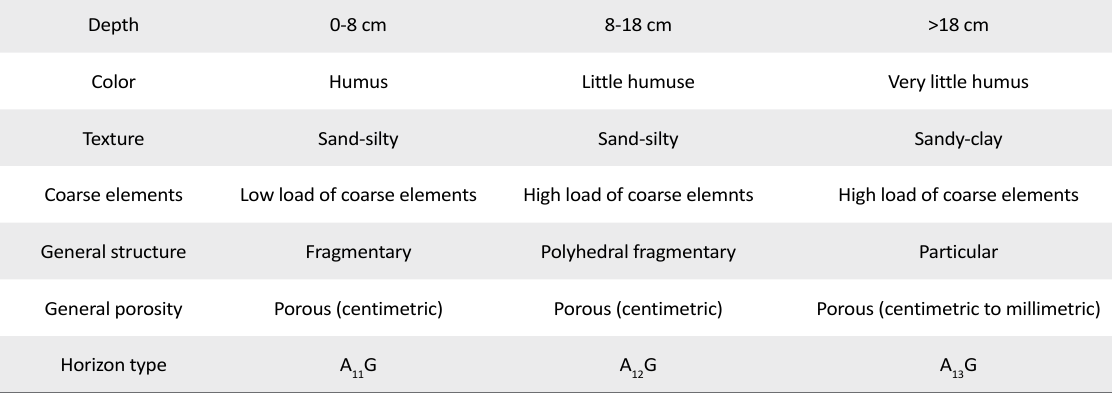
Table 2. Description of the soil profile in the lower slope of Yabayo Depth